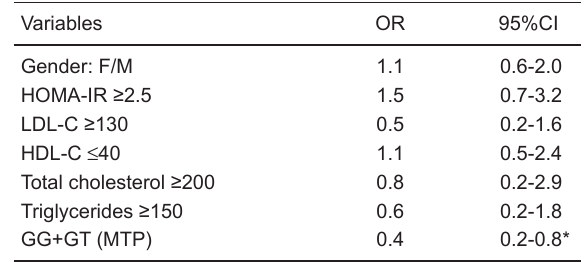
Table 5. Logistic regression analysis with fibrosis 3+4 as the de - pendent variable.